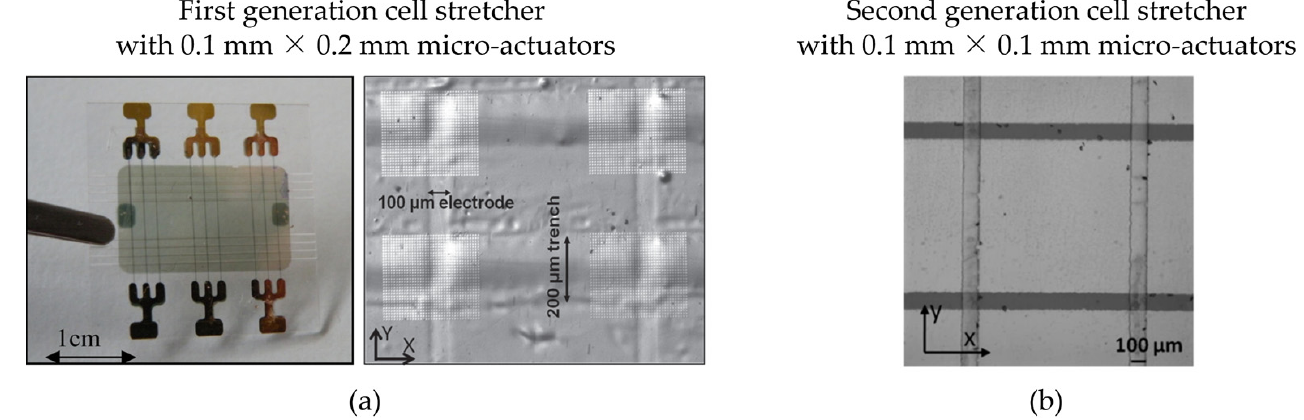
Figure 11. Examples of two ‐ dimensional DEA arrays operating in plane: ( a ) First generation cell stretcher based on a 8 ‐ by ‐ 9 array with of 0.1 mm × 0.2 mm micro ‐ actuators [146], reproduced with permission from IOP Publishing Ltd., copyright 2012; ( b ) Second generation cell stretcher based on 0.1 mm × 0.2 mm micro ‐ actuators [147], reproduced with permission from Elsevier, copyright 2012.